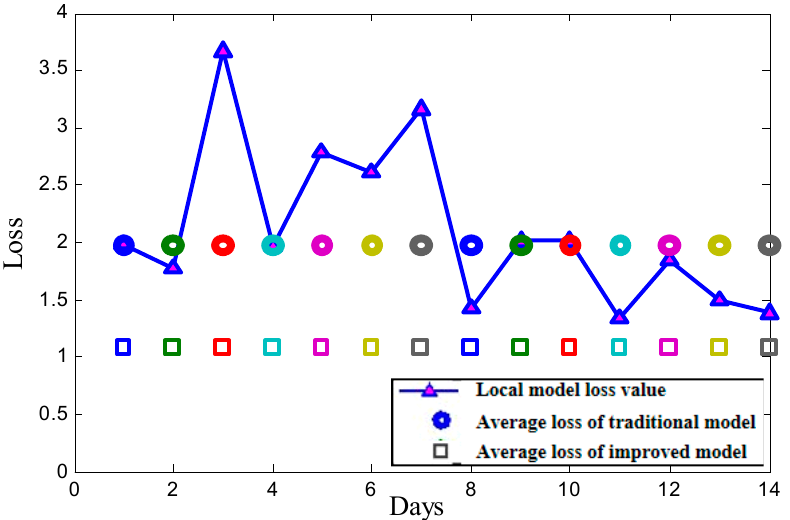
Figure 10. Comparison between the average loss of the improved model and the loss of the tradi- tional model.